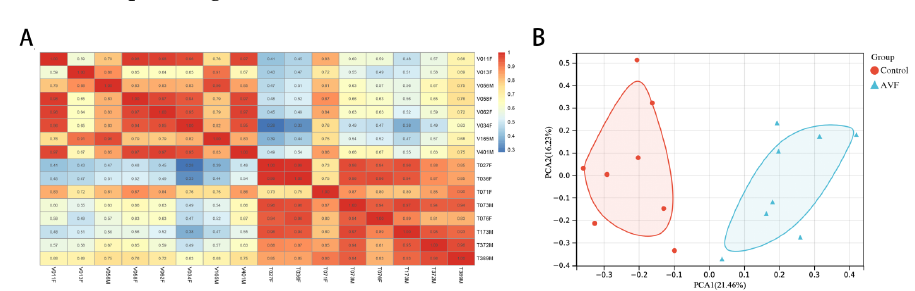
Figure 2. Characteristics of patients and validation of data from GSE119296. ( A ) The heatmap shows the correlation between intra-group data. ( B ) The selected samples from the dataset were analyzed using principal component analysis (PCA).